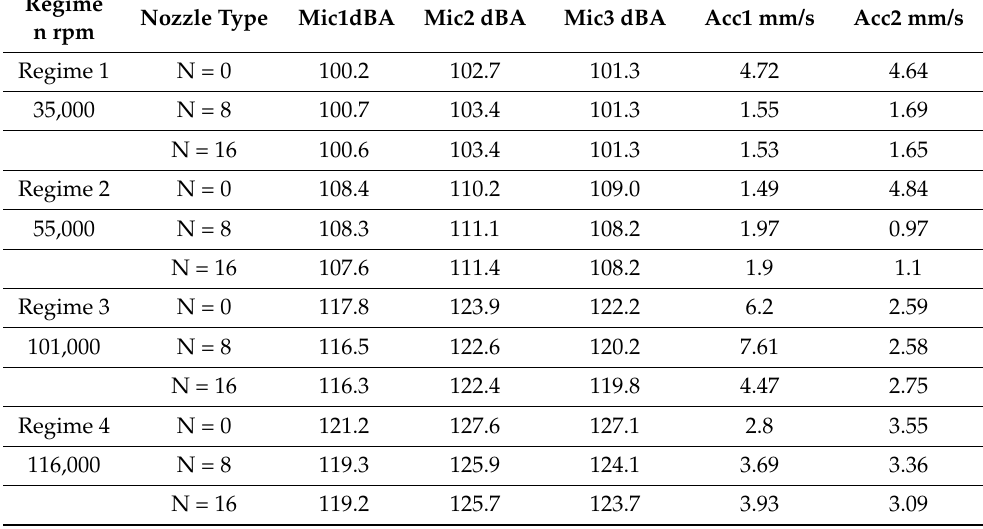
Table 1. Acoustic and vibrations results.